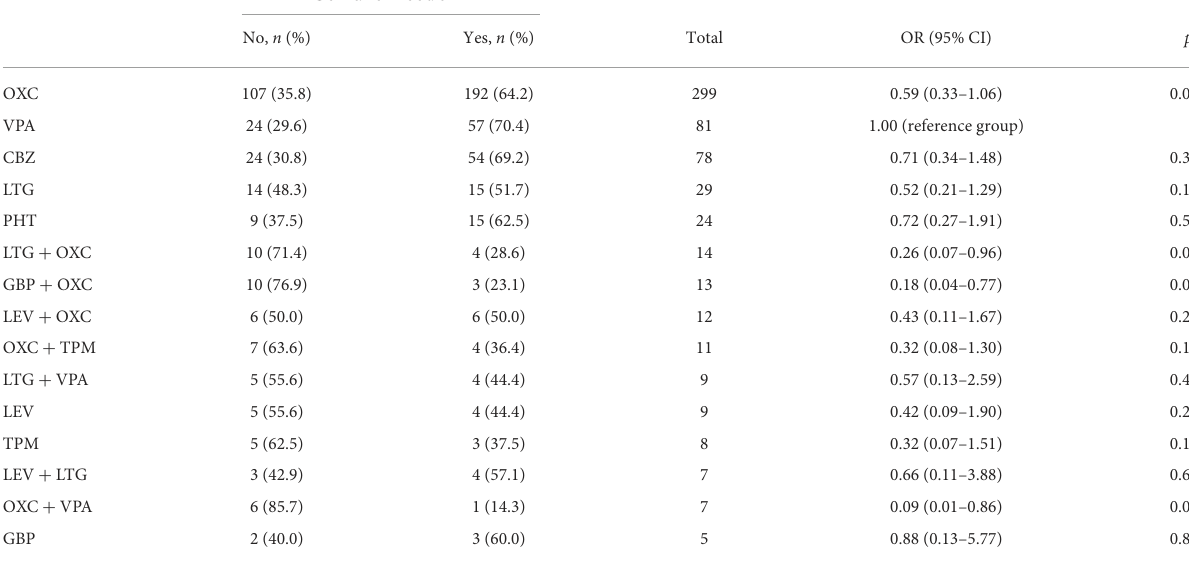
TABLE 6 Different substitutions or add-on combinations of antiseizure medications were used at least five patients. Seizure